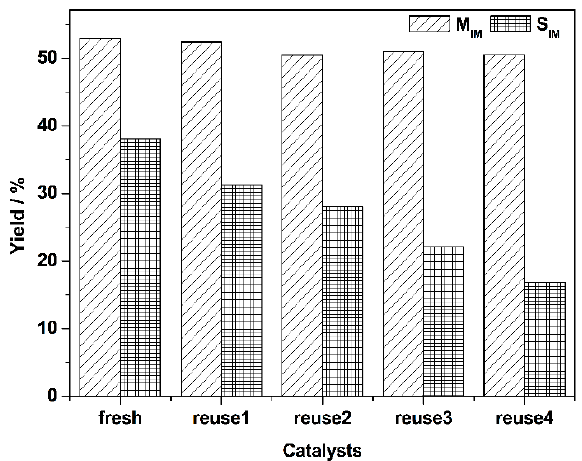
Figure 2. Comparison of the stabilities and reusabilities of 1% AuPd/TiO 2 (M Im ) and 1% AuPd/TiO 2 (S Im ) catalysts for the solvent free hydrogenation of NB to AN. Reaction conditions: nitrobenzene: 78 mmol, catalyst: 100 mg, temperature: 90 °C, H 2 pressure: 3 bar, time: 6 h.